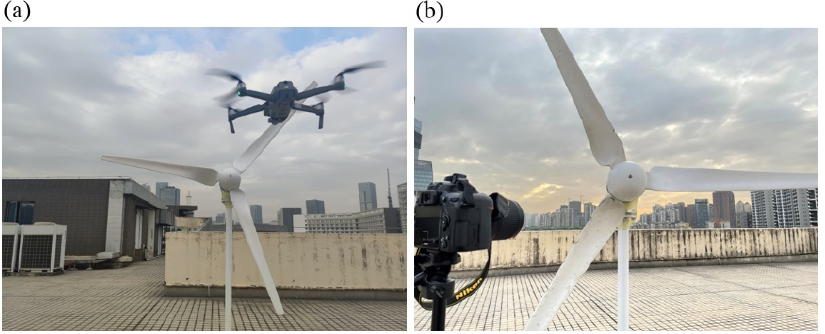
Figure 2. Image pair acquisition setup: ( a ) Imaging with a stably controlled UAV; ( b ) Imaging with a fixed camera. fixed